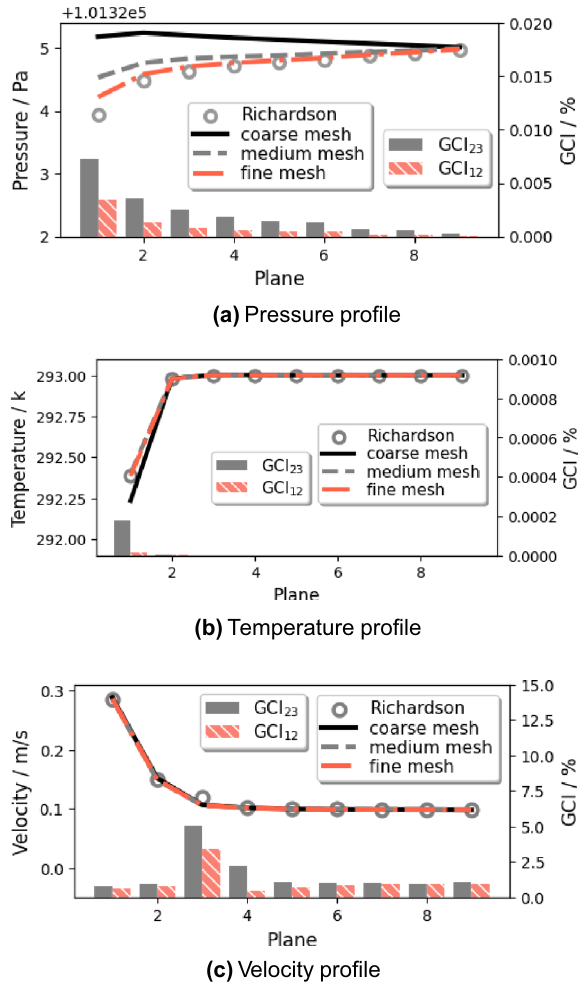
Figure 4. Grid independence study for three uniformly refined grids.